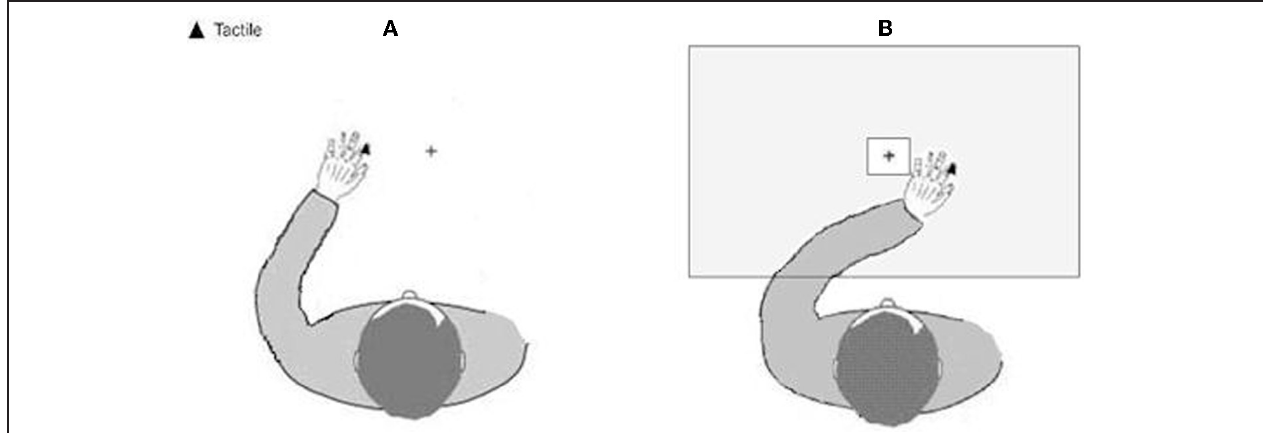
FIGURE 2 | Schematic representation of the experimental setup showing the position of the left hand. (A) in the left-hand side of space (homonymous), and (B) in the right-hand side of space (heteronymous). Tactile stimuli were applied to the tip of the participants’ left index finger.